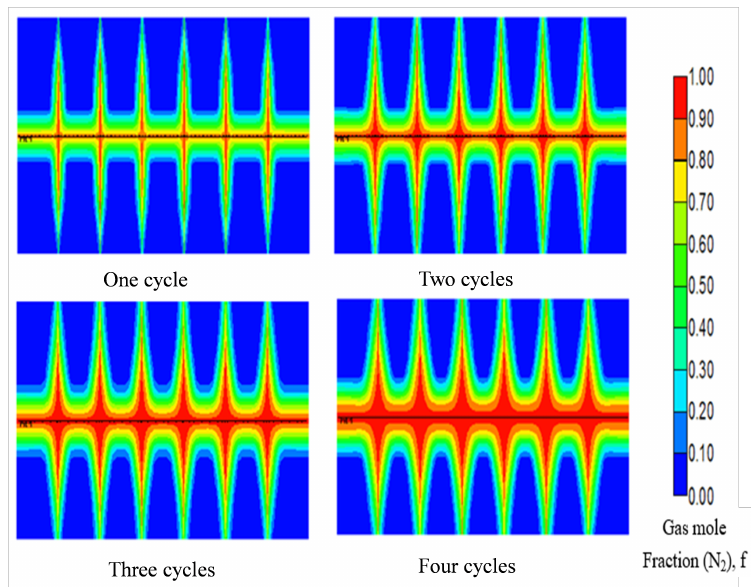
Figure 18. Distribution range of N 2 in different periods (mole fraction, increment 10%).